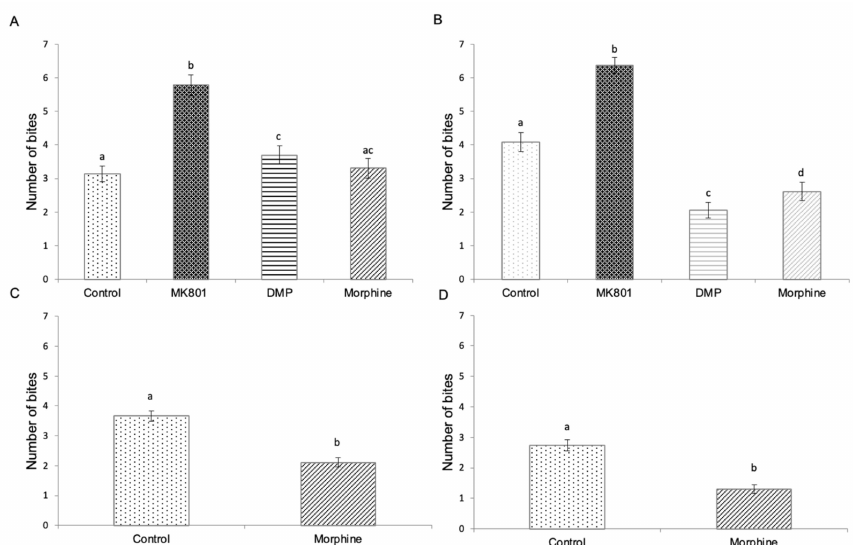
Figure 6. Mirror biting frequency of zebrafish larvae following ( A ) short-term (F (3,140) = 19.490, p = 0.001) and ( B ) long-term (F (3,140) = 56.224, p = 0.001) exposure to MK801, DMP and morphine, and ( C ) short-term morphine exposure followed by 5-day withdrawal ( t (70) = 5.278, p = 0.001) and ( D ) long-term morphine exposure followed by 5-day withdrawal ( t (70) = 8.830, p = 0.005). Data expressed as mean ± SEM, n = 36 of 3 independent experiments. Different lowercase letters indicate statistically significant values, p < 0.05. DMP: